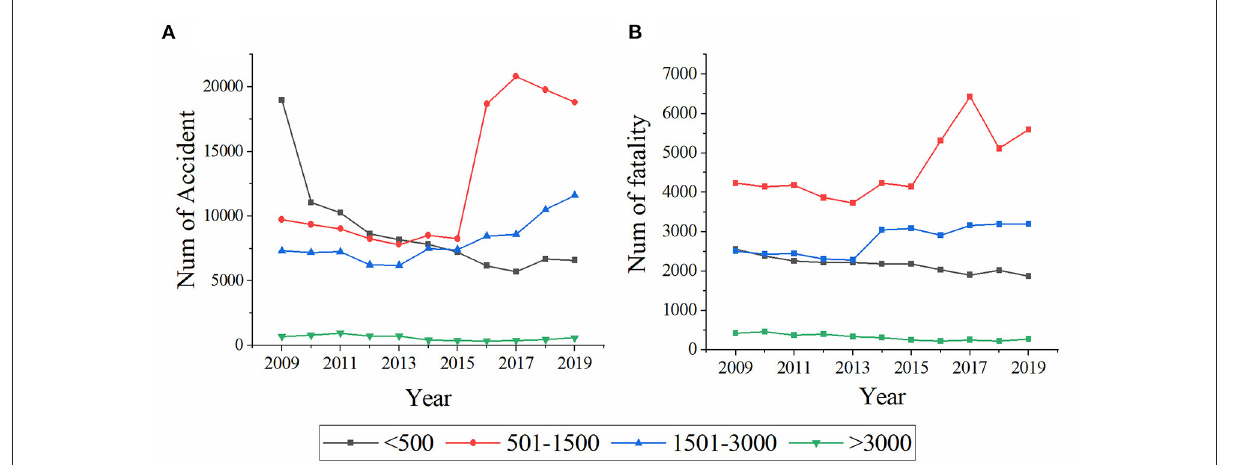
FIGURE2 Annual distribution of traffic accidents (A) and fatalities (B) at different altitudes.